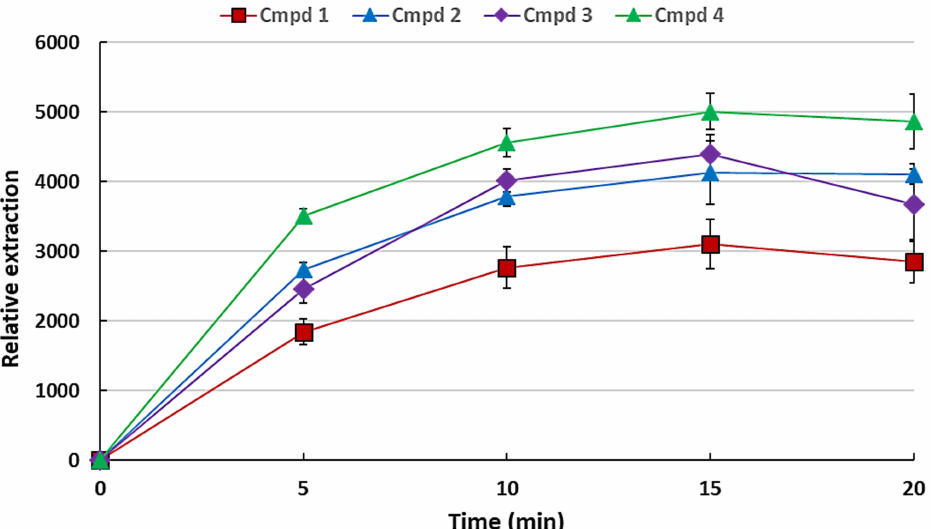
Figure 4. Variation of extraction time on the headspace SDME of the VOCs using 2 µ L heptadecane incubated at 55 ◦ C. The error bars indicate the standard deviation for n = 3